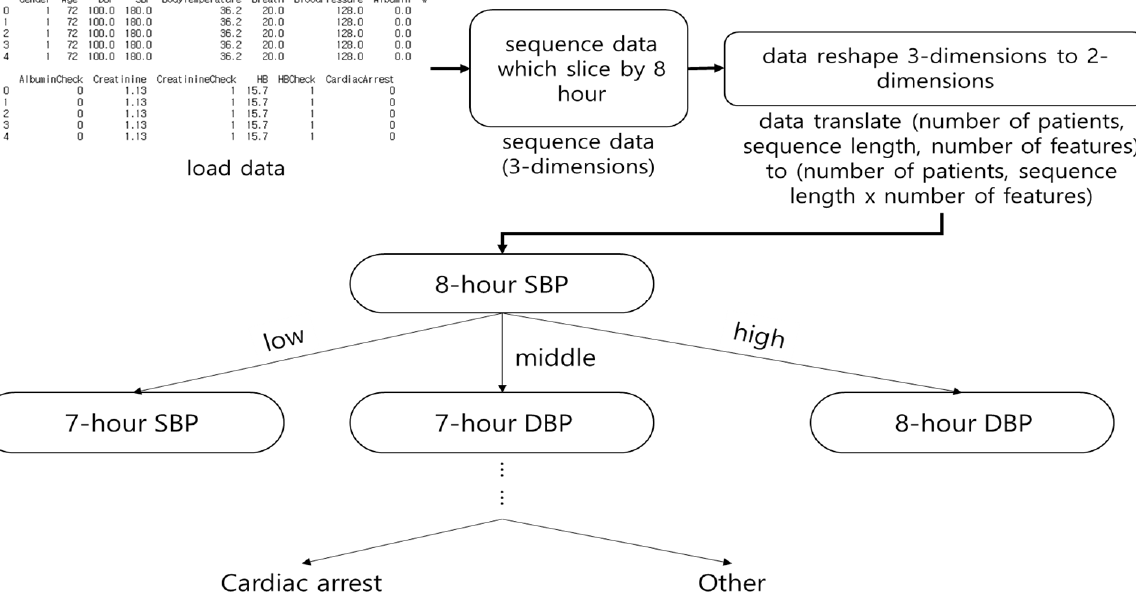
Figure 2. The architecture of Decision Tree (DT). The DT was classified by determining a range for all features (e.g., sex, age, pulse, and systolic blood pressure) to predict cardiac arrest.